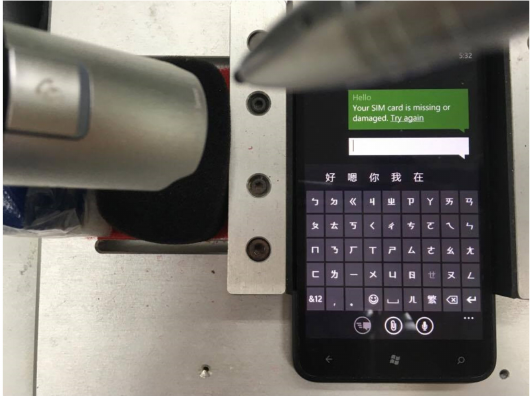
Figure 10. Right squares in target picture.